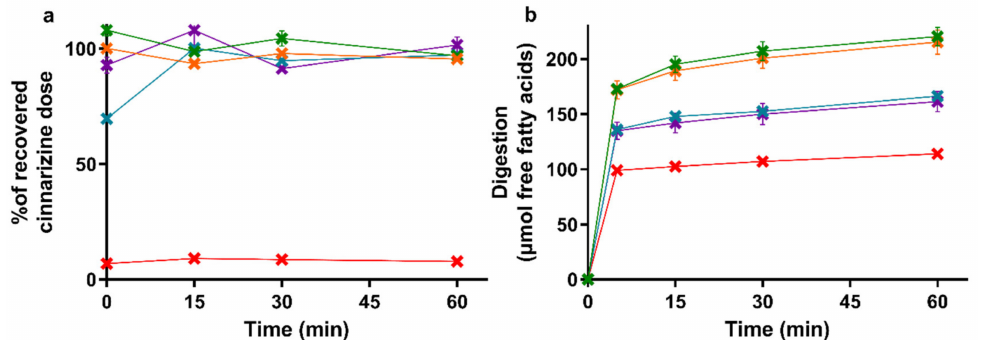
Figure 2. ( a ) Distribution of cinnarizine in the aqueous phase as percent of the total recovered dose after in vitro lipolysis of SNEDDS 80% (green), superSNEDDS suspension (blue), superSNEDDS solution (purple), the Chasing principle (orange), and aqueous suspension (red). ( b ) Lipolysis profiles of in vitro lipolysis at pH 6.5 of the same formulations. All data are represented as the mean ± SEM ( n =